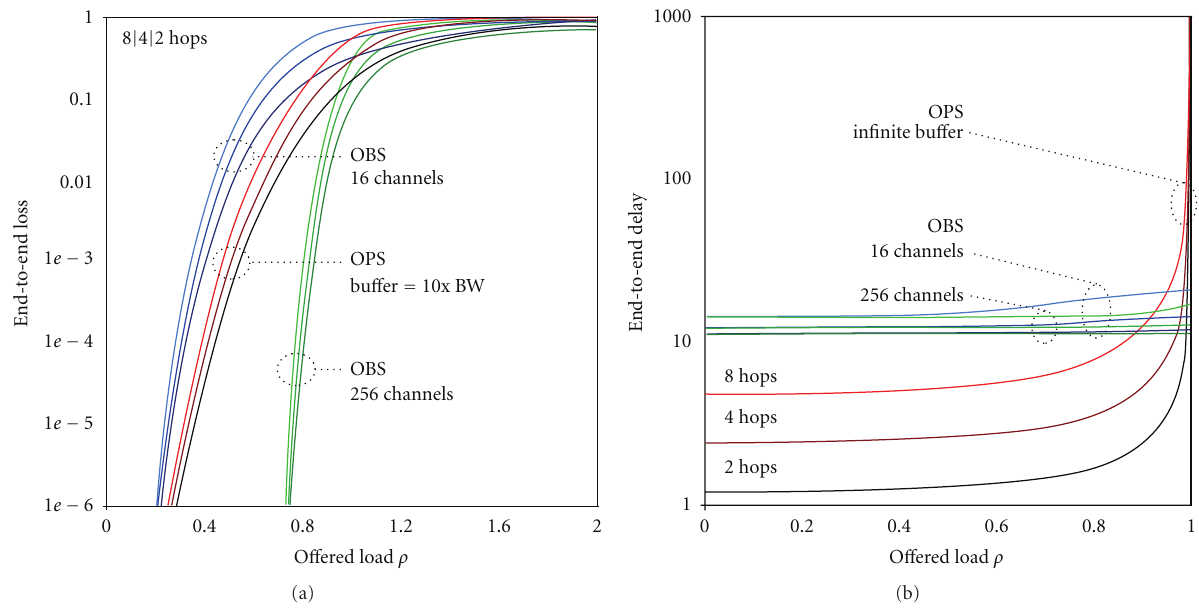
Figure 10: Loss and latency of OBS and OPS for di ff erent path